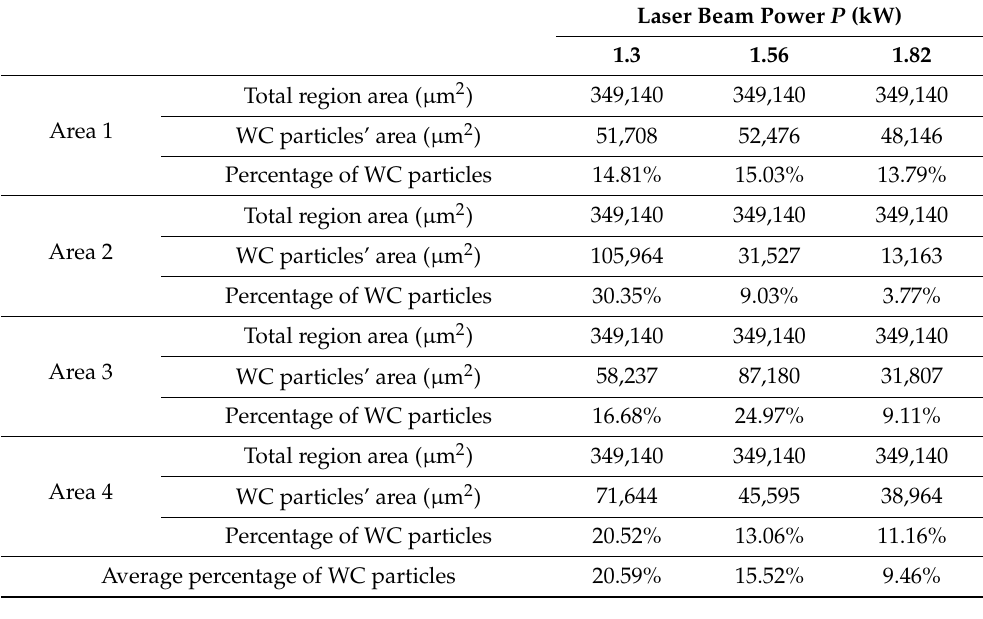
Table 2. Percentage of WC particles in the laser-alloyed layers enriched with WC particles.